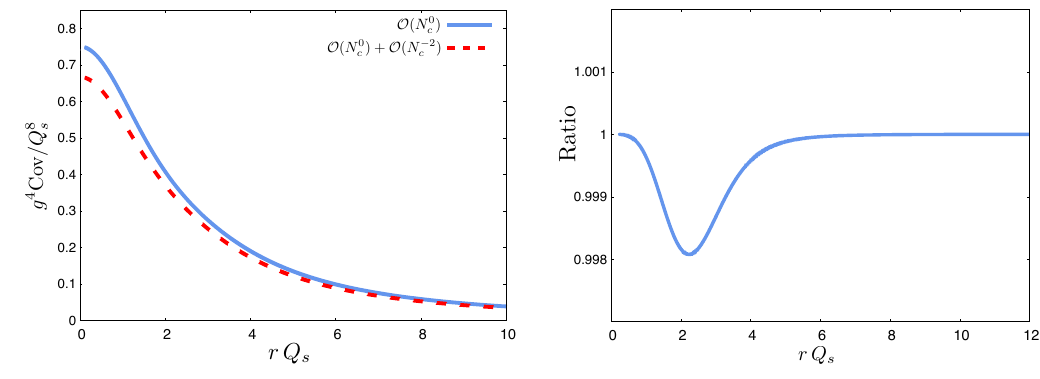
c -expansion of the energy density covariance -order term. Red dashed curve: sum of c